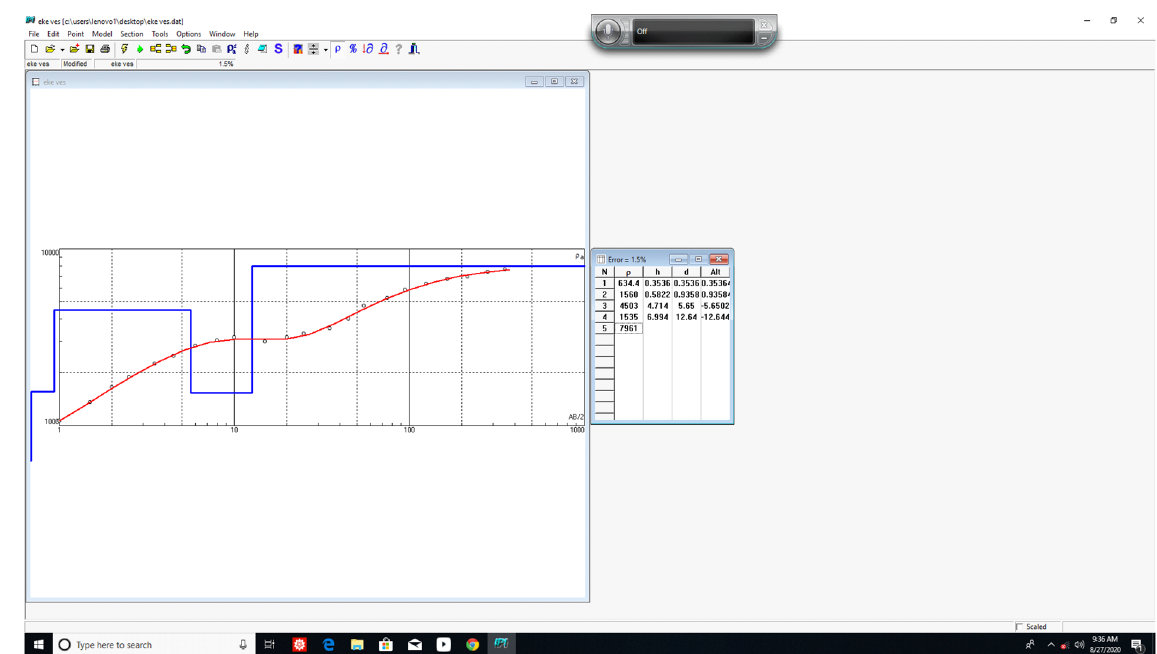
Fig. 5 AKQ-type curve for VES (2, 3 and 7)